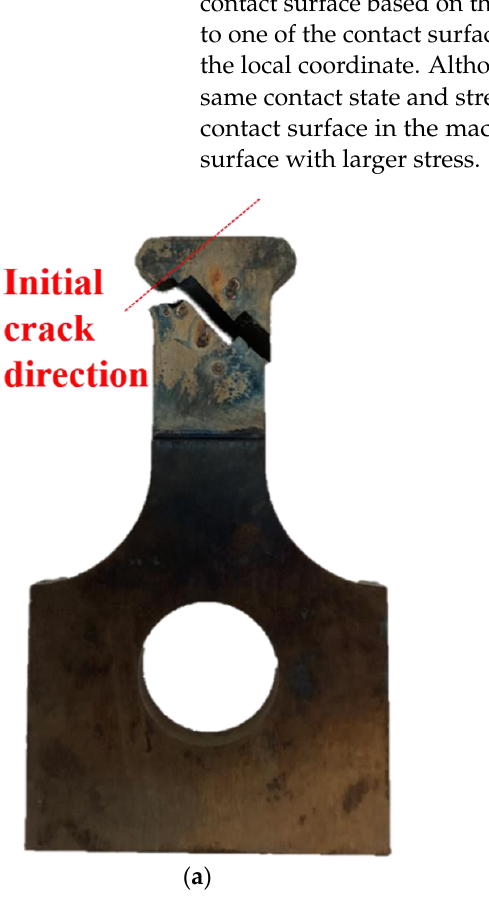
Figure 7. The fracture failure mode of dovetail specimens for different fretting loads. ( a )13,500N; ( b )16,451.6N.